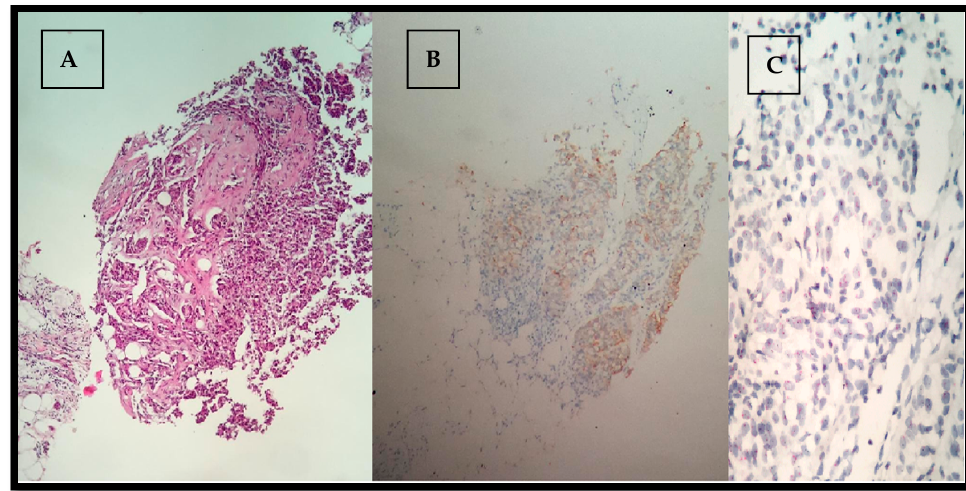
Figure 6. ( A ) HE, 20×, invasive ductal carcinoma (NST); ( B ) HER2neu IHC ++, 20×; ( C ) FISH Her2/neu: chromosome 17 > 2, 40×.